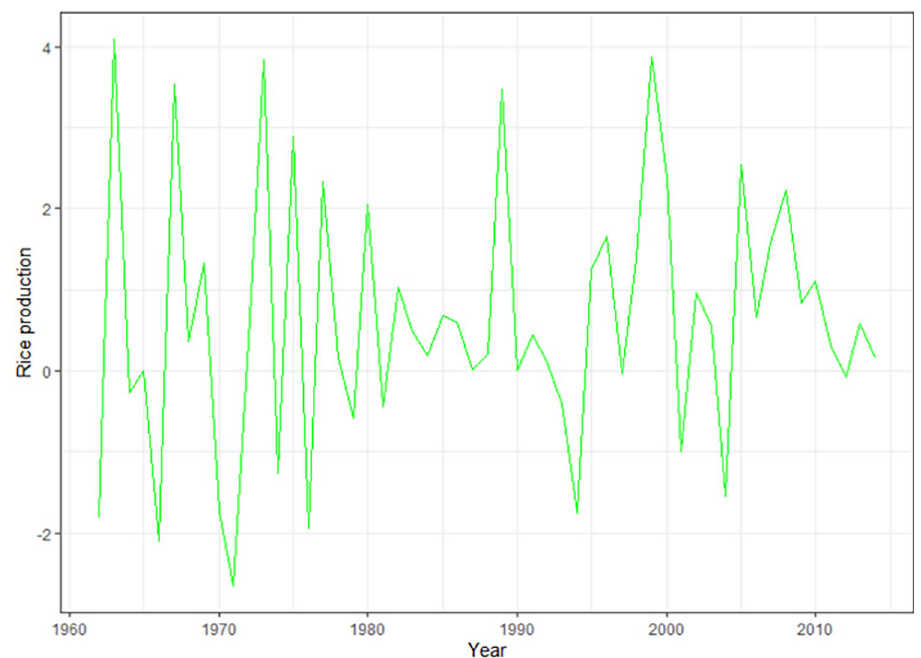
Fig 5. First-order differencing of the rice production of the training data set shows stationarity.